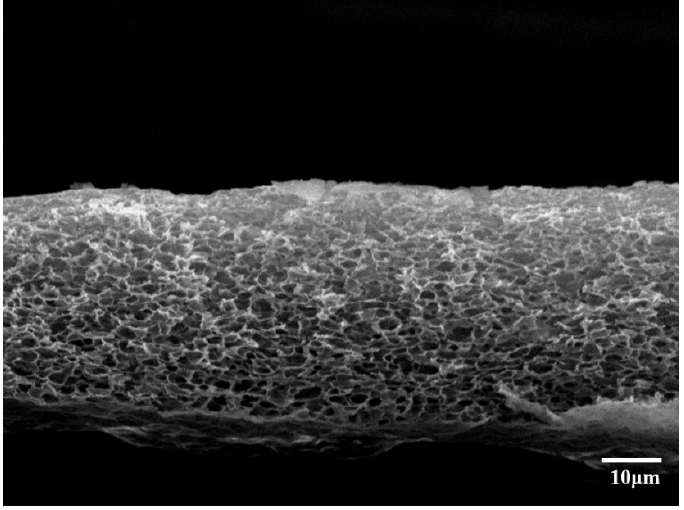
Figure 3. SEM images of 1:0.23 CA/Ni(NO 3 ) 2 ·6H 2 O film dissolved in acetone/water ( wt/wt 8:2) after water treatment at 8 bar.